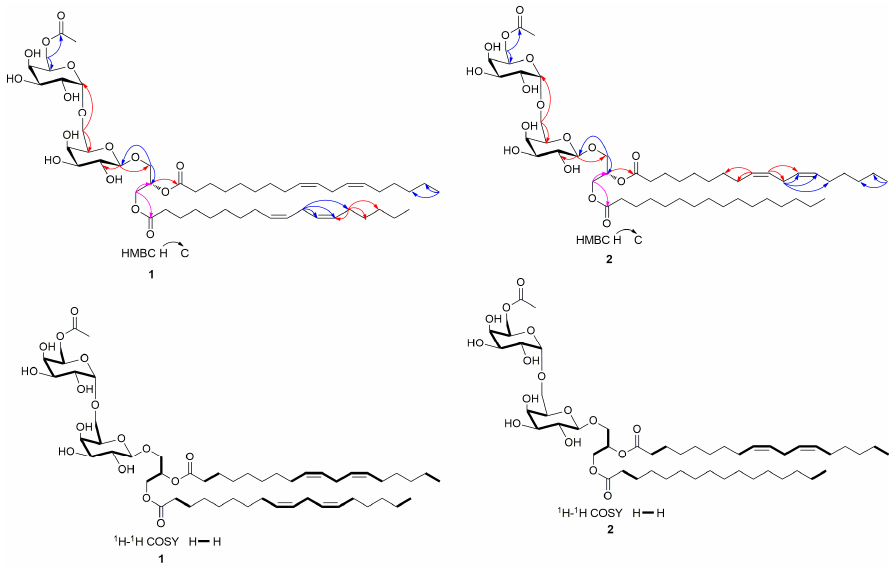
Figure 1. Chemical structure of compound 1 from Tubeufia rubra PF02-2.